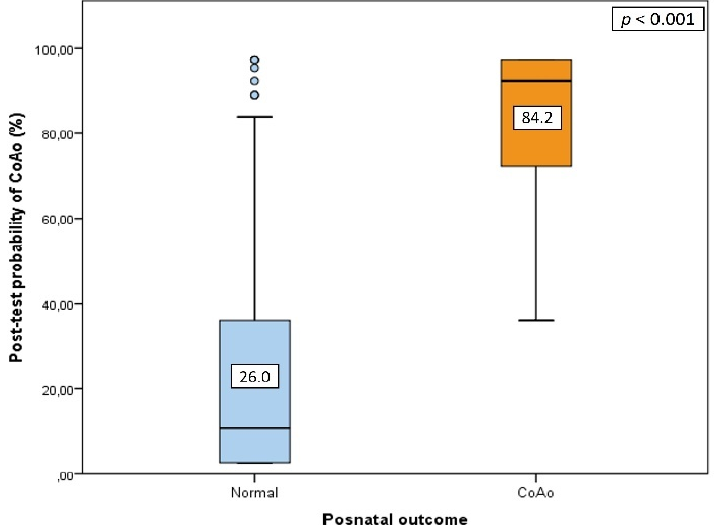
Figure 3. Box-and-whisker plot illustrating the distribution of post-test probability of coarctation of the aorta (CoAo) according to postnatal outcome by applying our global multiparameter score. Solid horizontal lines inside boxes correspond to median values, while the interquartile range (IQR) is represented by boxes. Whiskers show range. Values beyond 1.5 IQR from 25th and 75th centiles are shown by extreme points. Numbers in boxes indicate mean values.